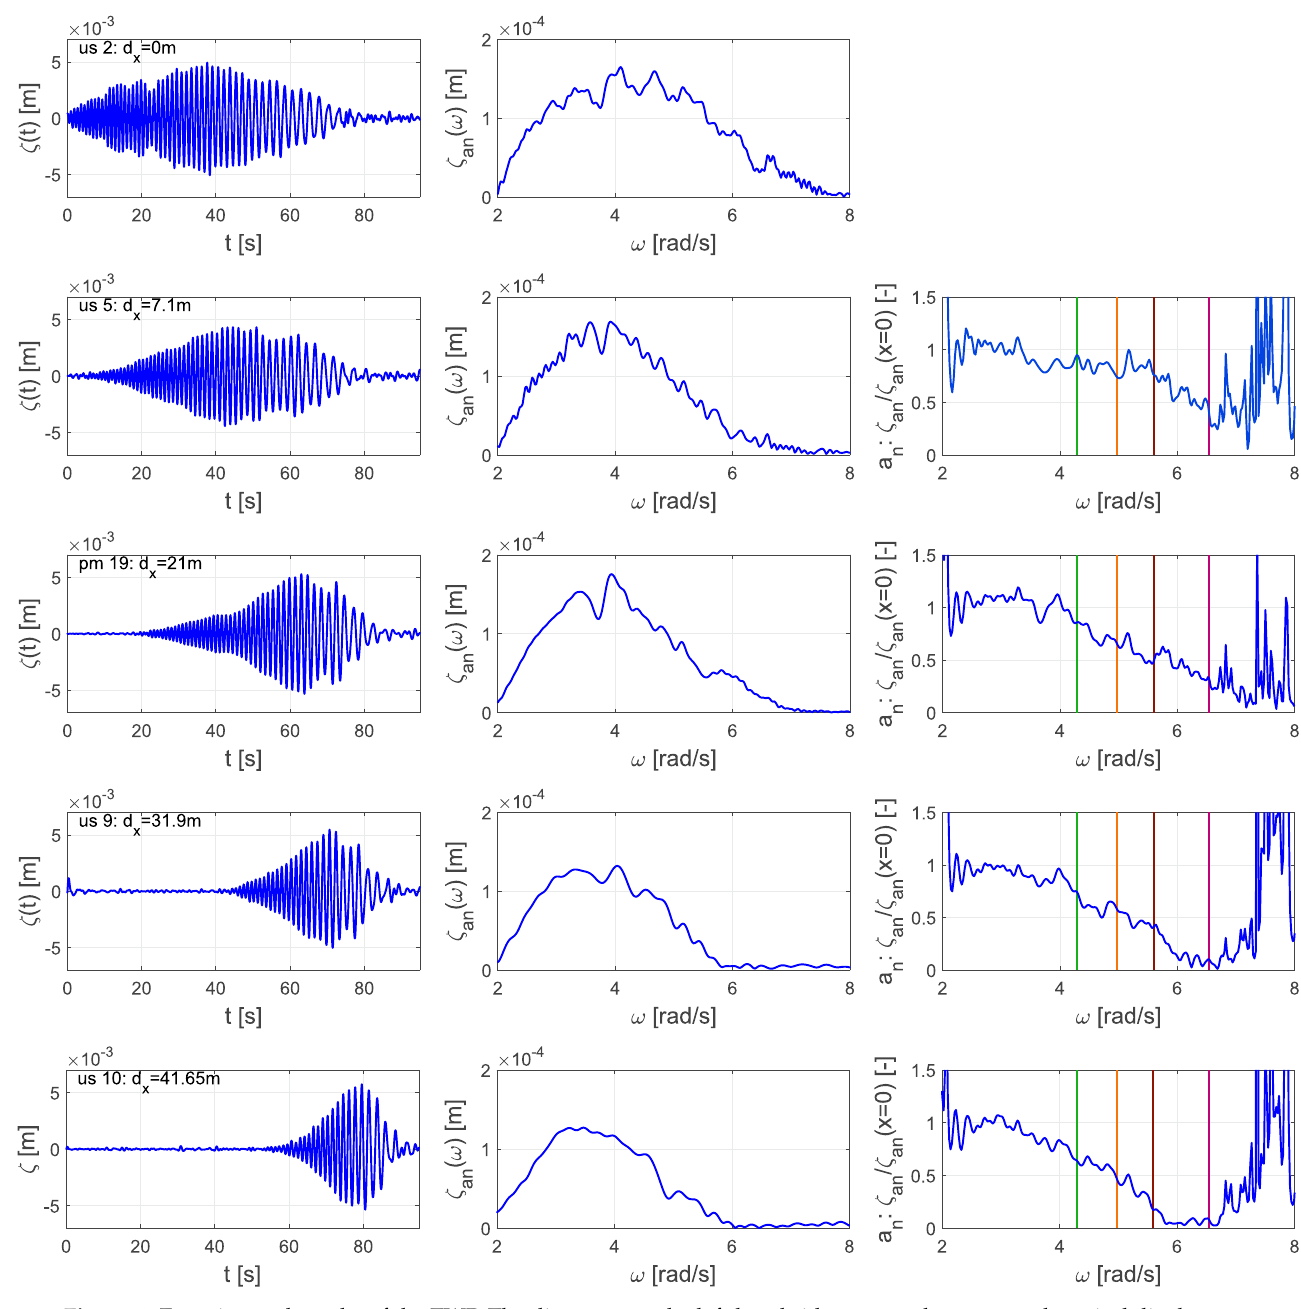
Figure 4. Experimental results of the TWP. The diagrams on the left-hand side present the measured vertical displacement of the ice for specific locations along the tank. The centre diagrams show the corresponding amplitude spectrum and the diagrams on the right-hand side show the determined attenuation coefficient. The four coloured vertical lines in the diagrams on the right-hand side represent the position of the investigated regular waves within the TWP frequency